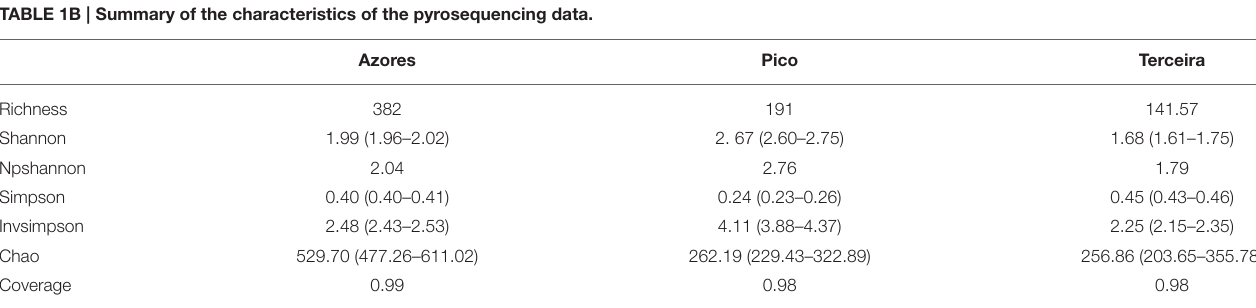
TABLE 1B | Summary of the characteristics of the pyrosequencing data. Azores Pico